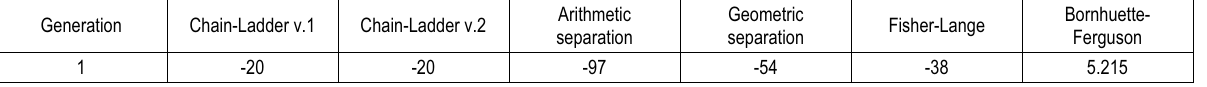
Table 6. Bias method of backward calculated random development